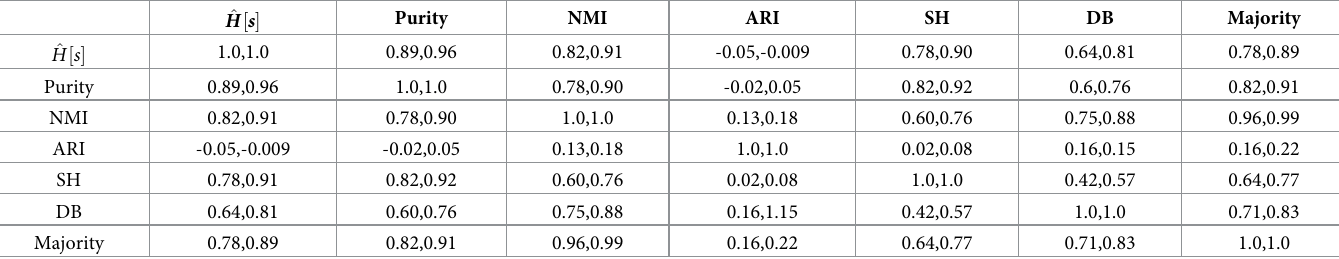
Table 6. Kendall’s τ and Spearman’s correlation result for Crime (auto). ^ H ½ s